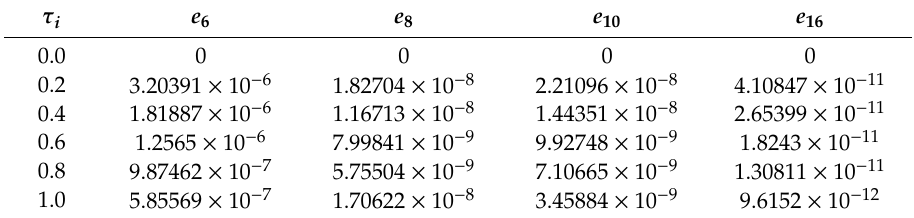
Table 4. Comparing absolute errors of RC collocation method for di ff erent values of N .